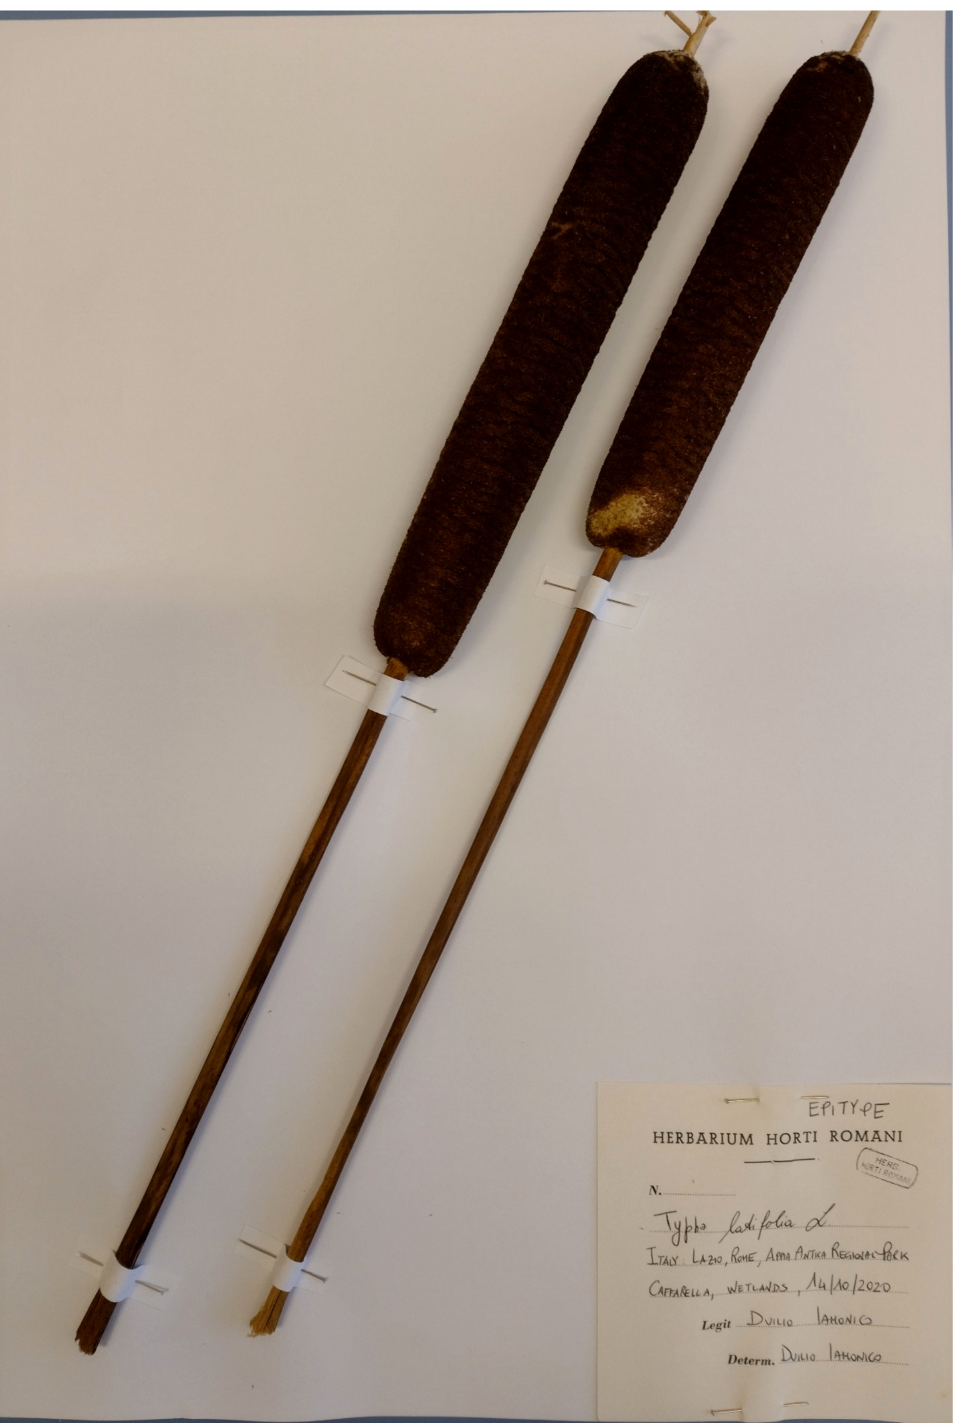
Figure 74. Epitype of Typha latifolia (RO